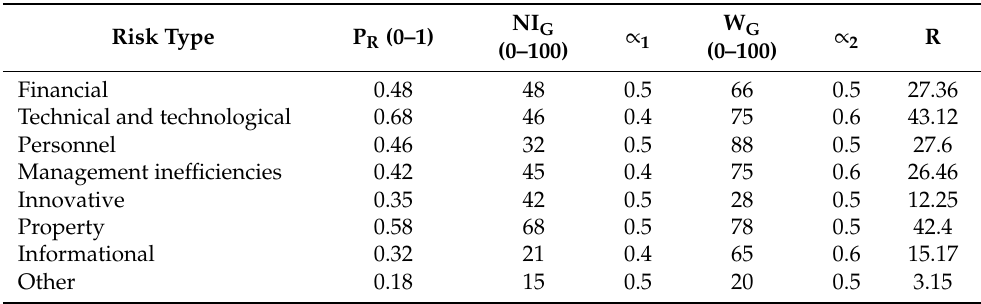
Table 3. The results of an expert assessment of the internal risks of enterprises of the “Valley of Mechanical Engineering” cluster, 2018 year.